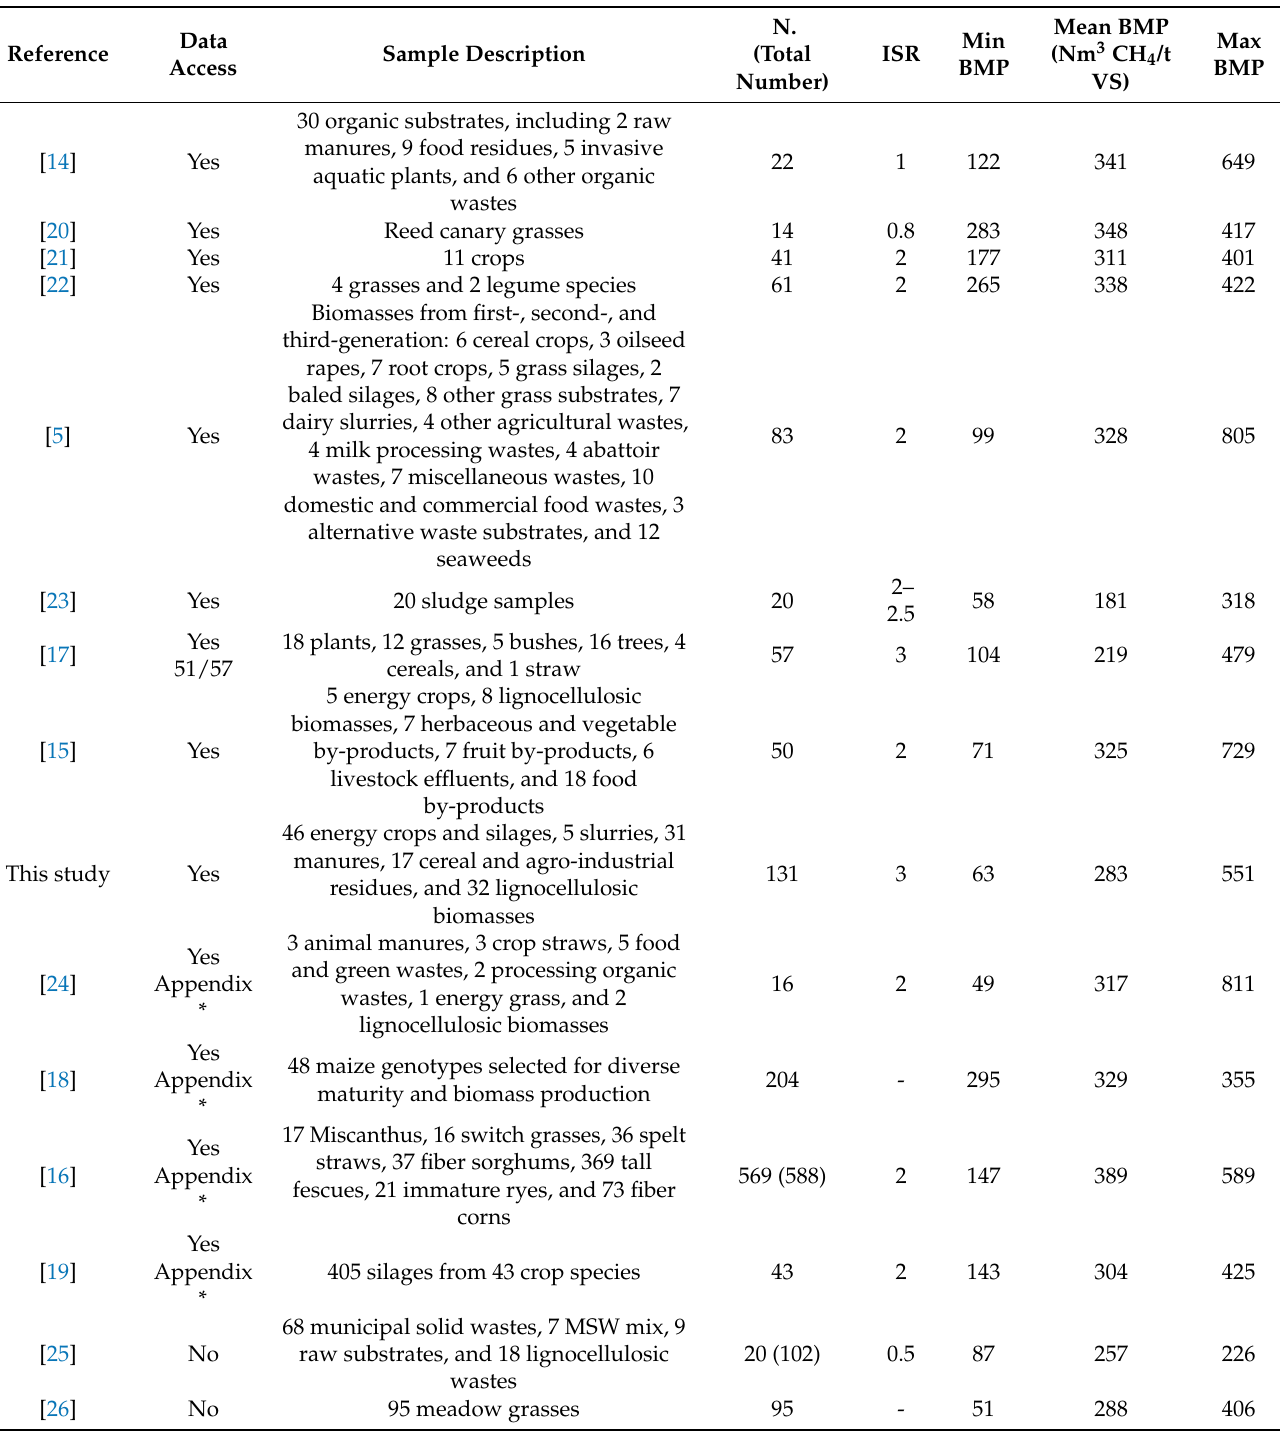
Table 1. Literature data on large sets of BMP references for organic substrates. N.: number of samples, ISR: inoculum–substrate ratio, MSW: municipal solid wastes, and WWTP: wastewater treatment plant. Description of the samples can be found in the Appendix